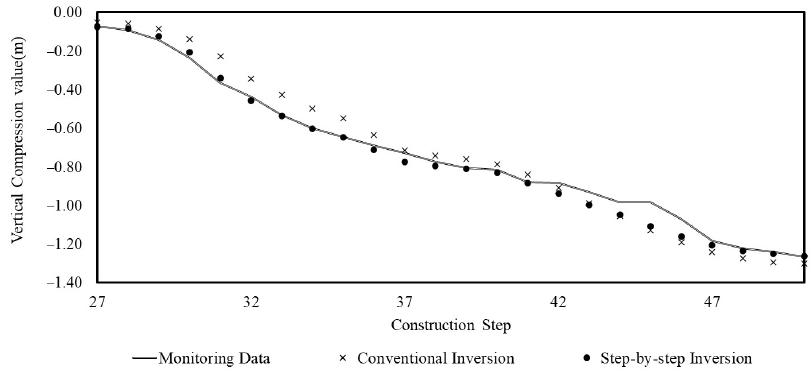
Figure 8. Comparison of compression values of the bottom of the core wall.